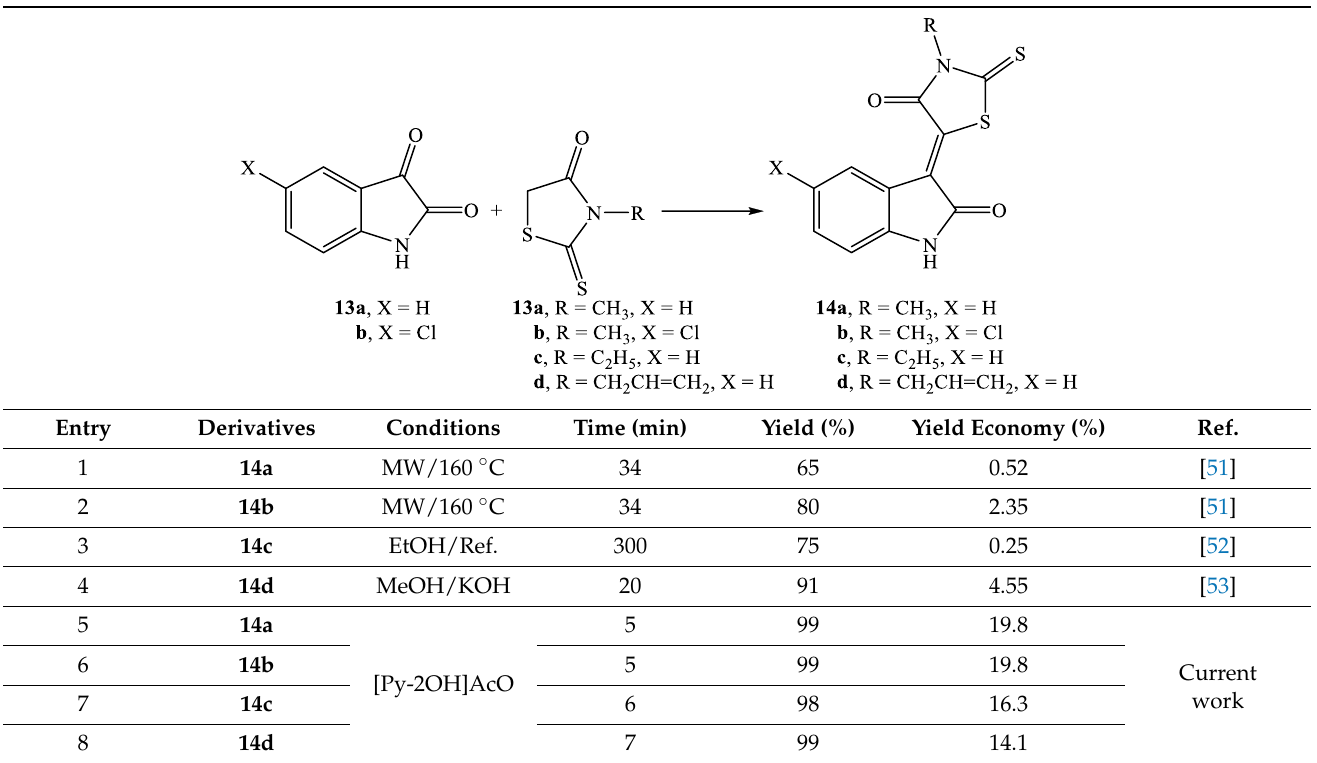
Table 2. Knoevenagel condensation of isatins with rhodanines under different conditions.